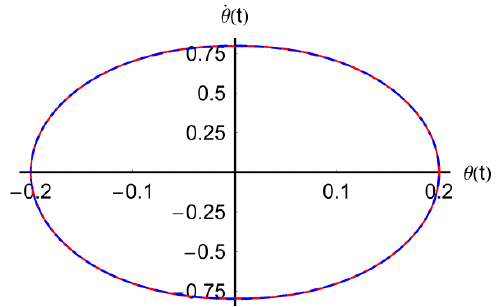
Figure 20. Comparison between the approximate solution (50) and numerical integration results for Figure 21. Phase plane for A = 0.4, L = 0.6. Figure 8. Comparison between the approximate solution (42) and numerical integration results for A = 0.2, a = 0.2, L = 0.6.